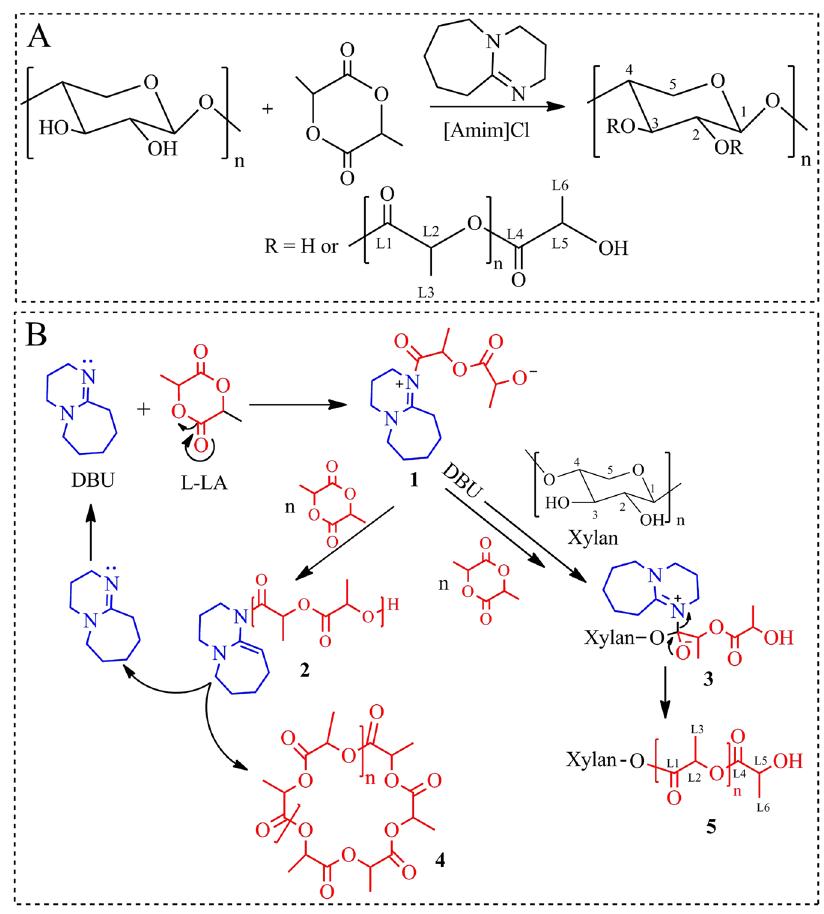
Figure 1. The grafting copolymerization of PLA onto xylan in [Amim]Cl with organic catalyst DBU ( A ) and the possible mechanism ( B